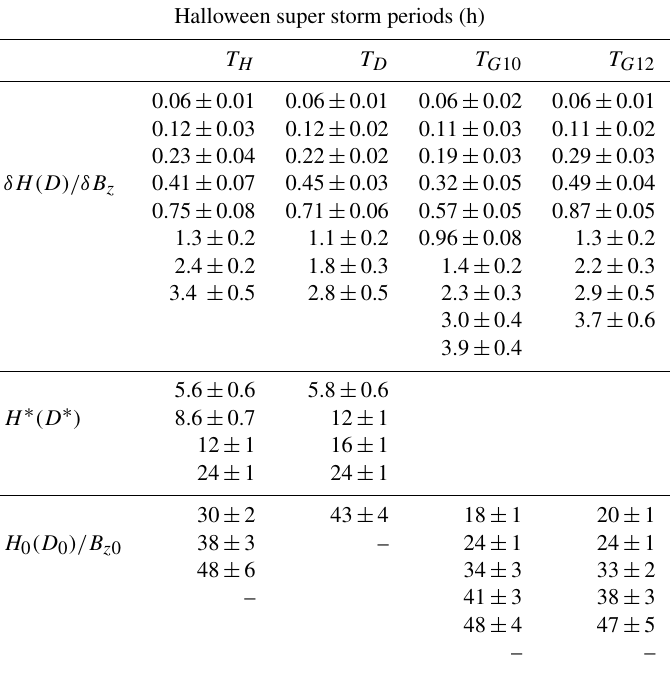
Table 2. Mean periods of intrinsic modes during the Halloween storm (the dash corresponds to the period of the residue r(t) which cannot be evaluated).